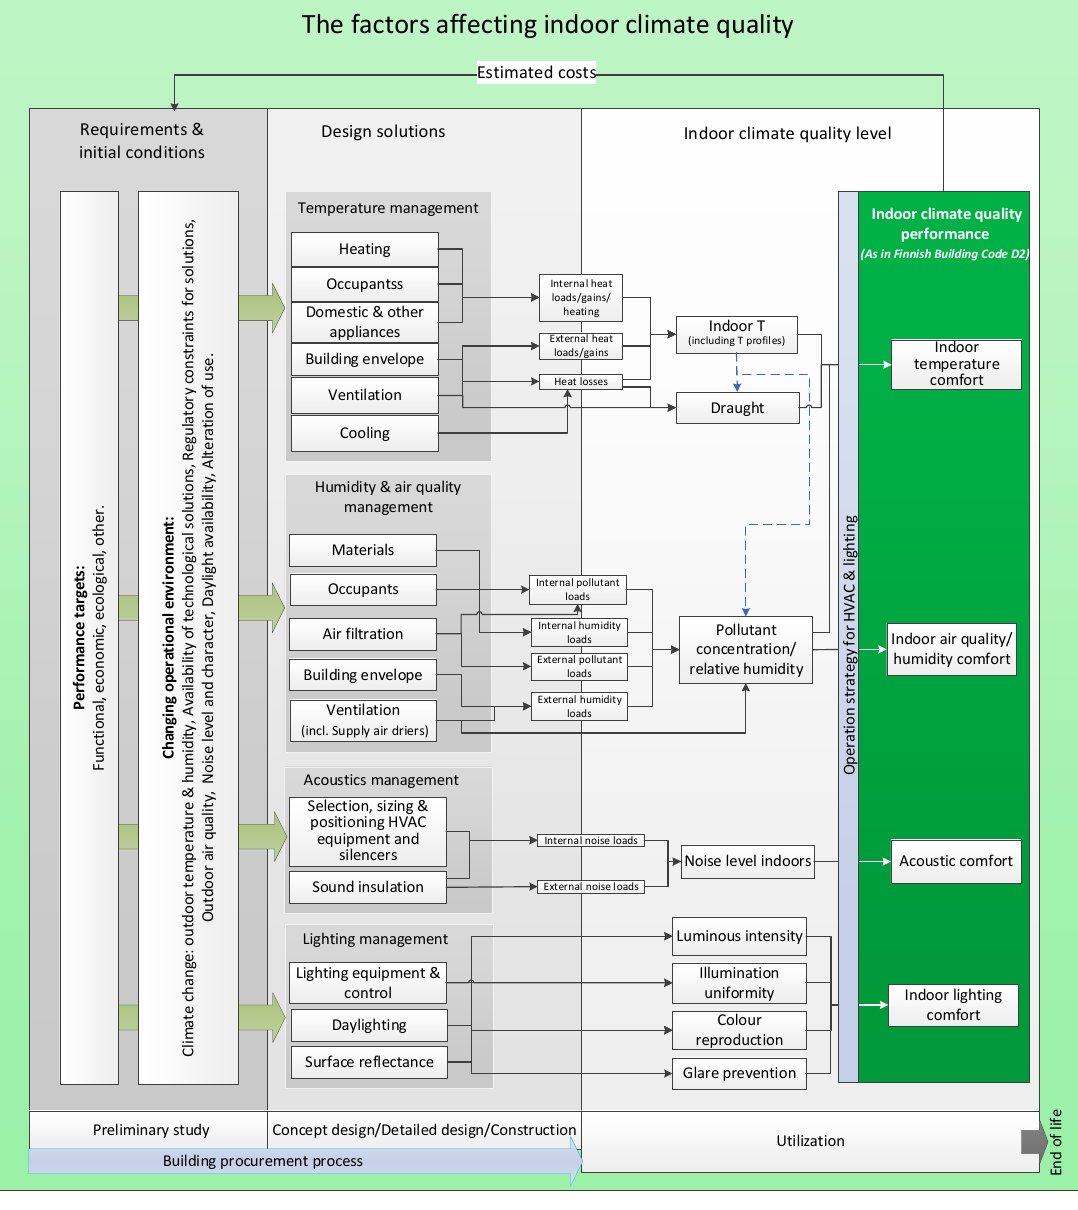
Figure 5. The identification of the factors affecting indoor climate quality in a building.